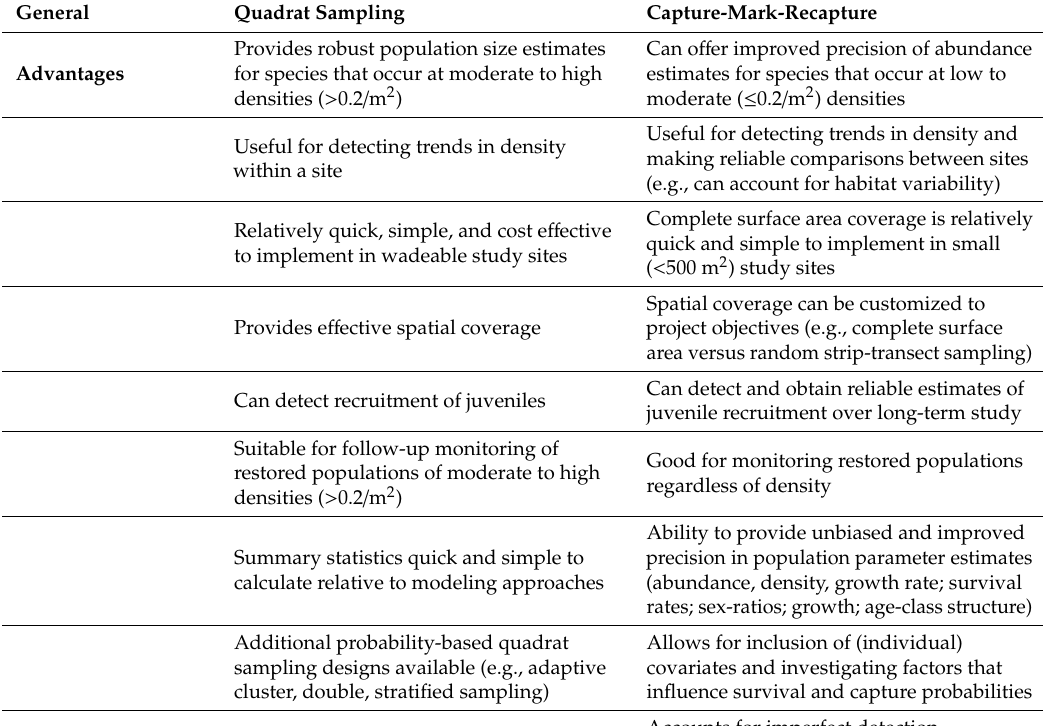
Table 6. Summary of the general advantages, disadvantages, and recommendations regarding quadrat and capture-mark-recapture (CMR) sampling approaches to monitoring freshwater mussels. Note that the information provided in this table should not be viewed as all-encompassing or applicable to all situations and